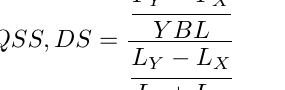
Evolution of QSS over each TR for HMPE#1.